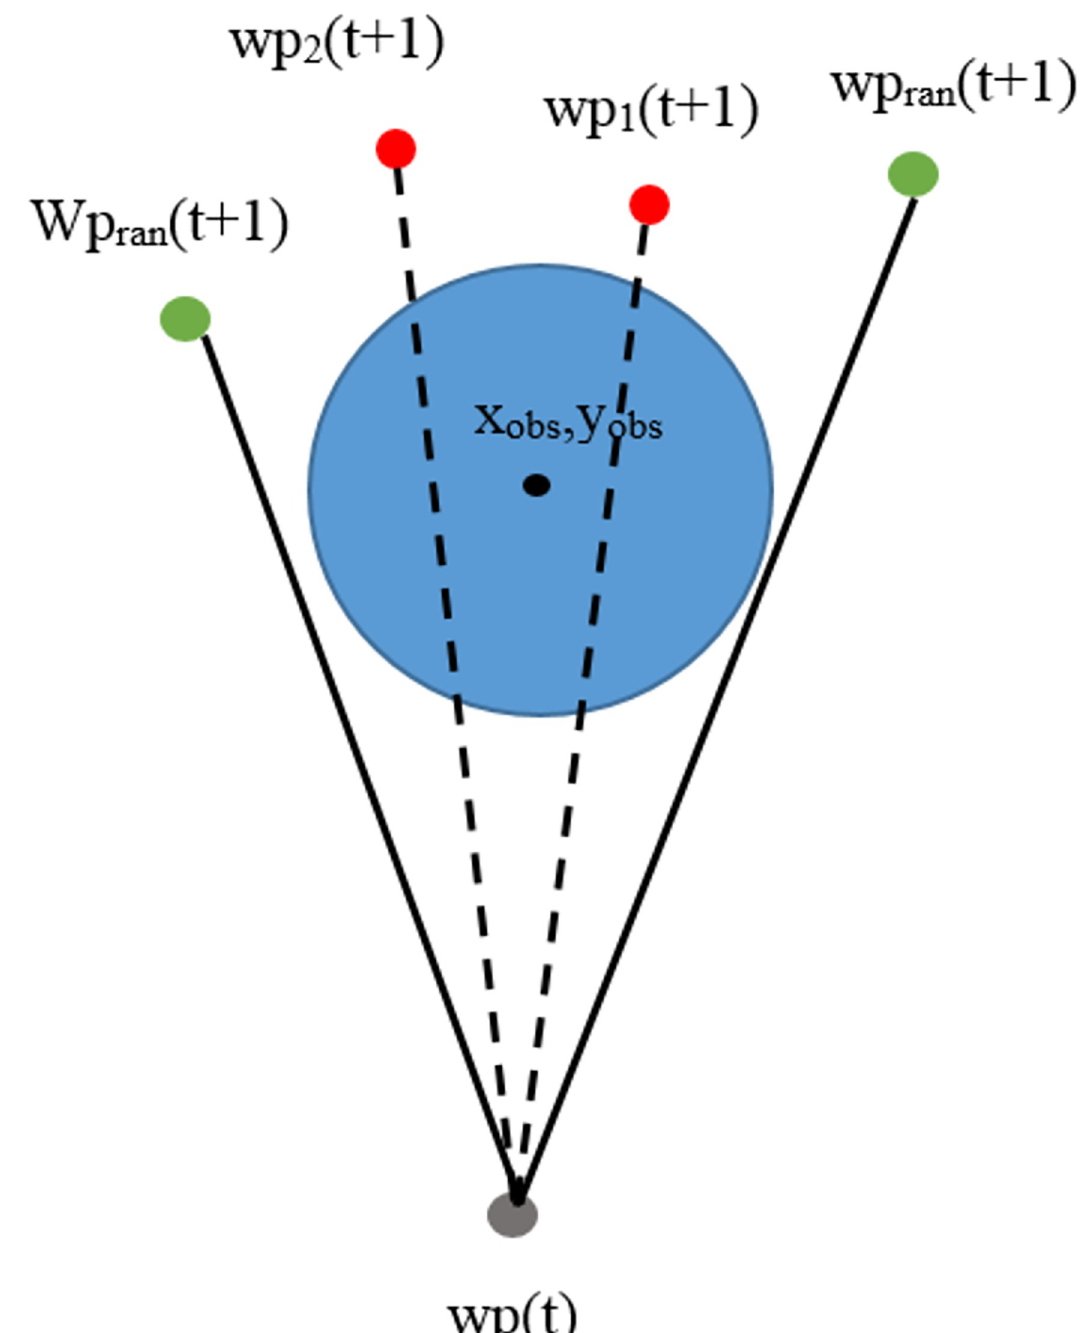
Fig 15. How to address infeasible waypoints when obstacles block